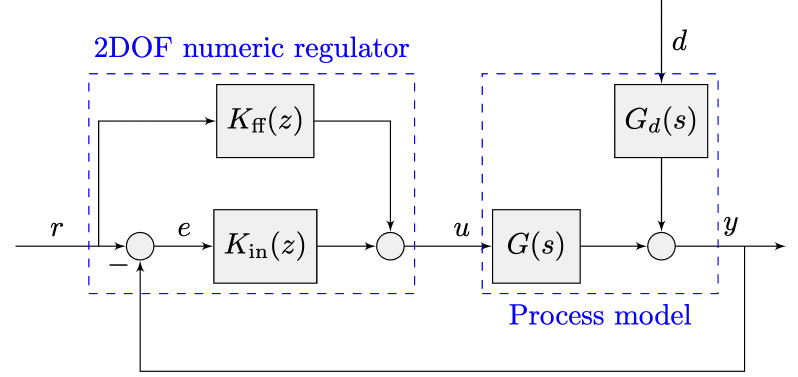
Figure 1. Numeric regulator K T ( z ) with a specified sampling rate T > 0 and its corresponding interface consisting of a sample and hold with the analog-to-digital converter, along with the digital- to-analog converter followed by a sample and hold circuit.